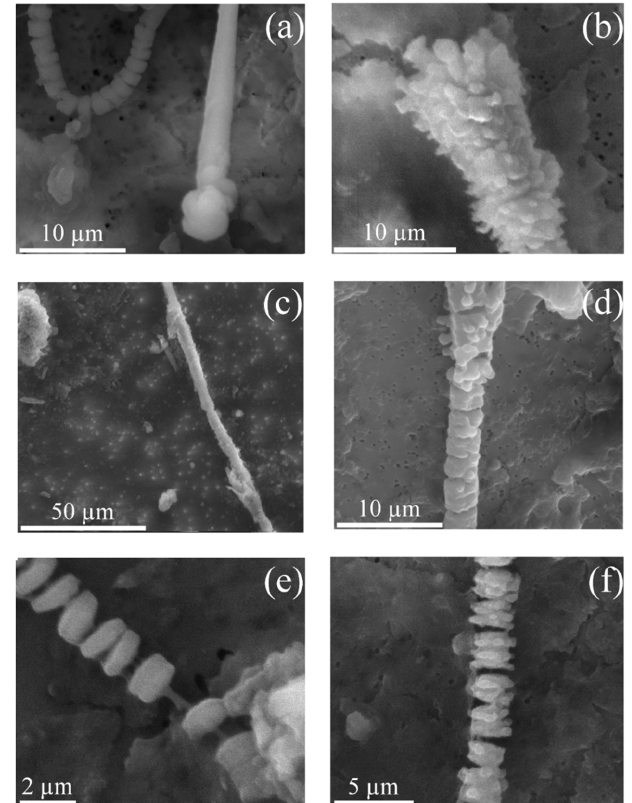
Figure 9. FEG-SEM images of asbestos bodies found in the lung of the human subject. ( a ) Typical sub-rounded AB segments at the tips of fibres. ( b ) The AB at the fibre tip showing typical multiple sequences of coatings. ( c , d ) ABs showing a habit in which the individual segments are fused (or partially-fused) together; ( e ) disc-shaped beaded segments; ( f ) disc-shaped segments partially-fused.